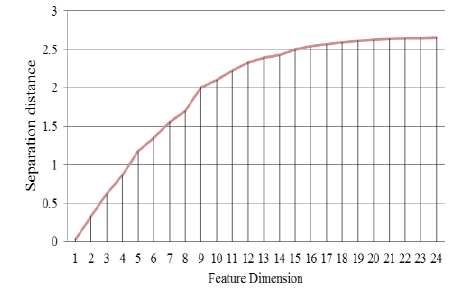
Figure 4 Curve map of separation distance and